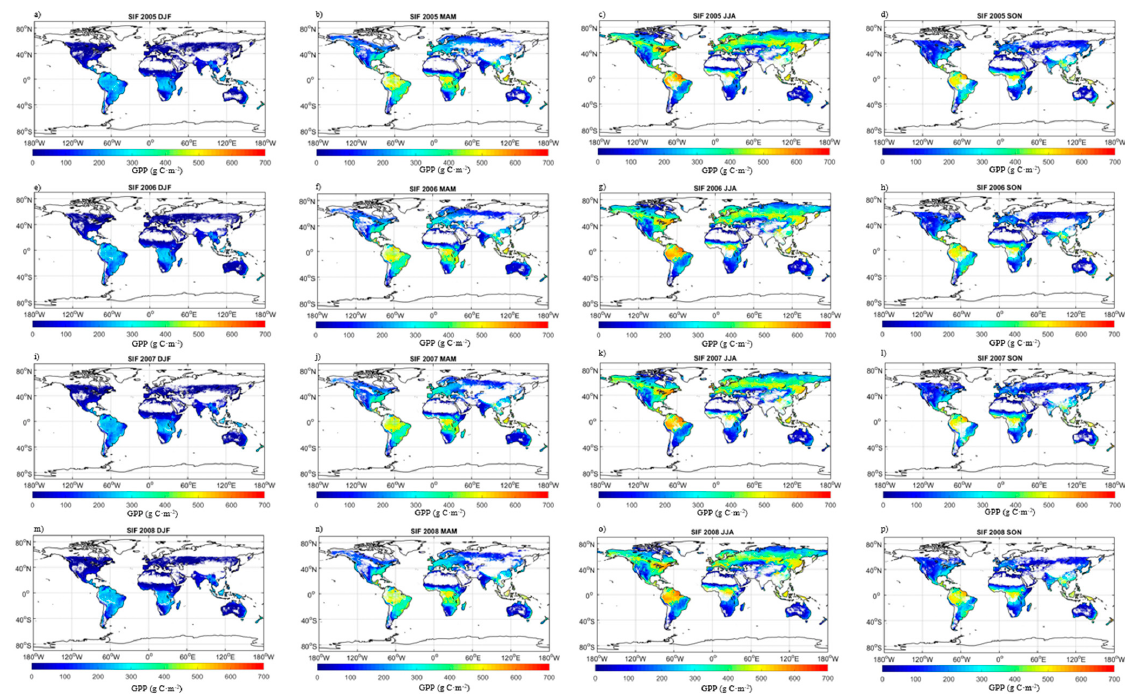
Figure A2. Spatial patterns of global GPP in different seasons: ( a ) GPP SIF in DJF of 2005; ( b ) GPP SIF in MAM of 2005; ( c ) GPP SIF in JJA of 2005; ( d ) GPP SIF in SON of 2005; ( e ) GPP SIF in DJF of 2006; ( f ) GPP SIF in MAM of 2006; ( g ) GPP SIF in JJA of 2006; ( h ) GPP SIF in SON of 2006; ( i ) GPP SIF in DJF of 2007; ( j ) GPP SIF in MAM of 2007; ( k ) GPP SIF in JJA of 2007; ( l ) GPP SIF in SON of 2007; ( m ) GPP SIF in DJF of 2008; ( n ) GPP SIF in MAM of 2008; ( o ) GPP SIF in JJA of 2008; ( p ) GPP SIF in SON of 2008.